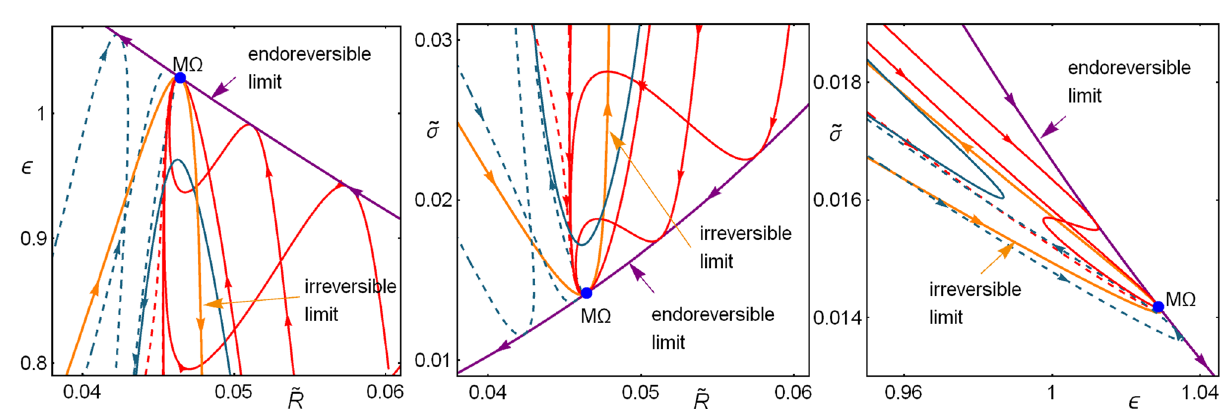
Figure 3. Dynamics given by solving Eqs. (9) and (10) with given initial conditions. In all cases C 2 ( 2 τ)/(τ( 1 τ)) and three cases for D are depicted: in column ( a ) D = − − D 1 / 2 . In the first row, the line integral convolution plot, simulating 3 / 2 C ; with τ 3 / 5 and � c = = = streamlines of fixed arc length over a set of random conditions. For the second raw, continuous (dashed) lines 1 ( α 0 ). Red curves are located inside the basin of stability. The endoreversible limit is denoted start at α (cid:31) → → by a vertical (purple) line and the irreversible limit by a horizontal (yellow) line.